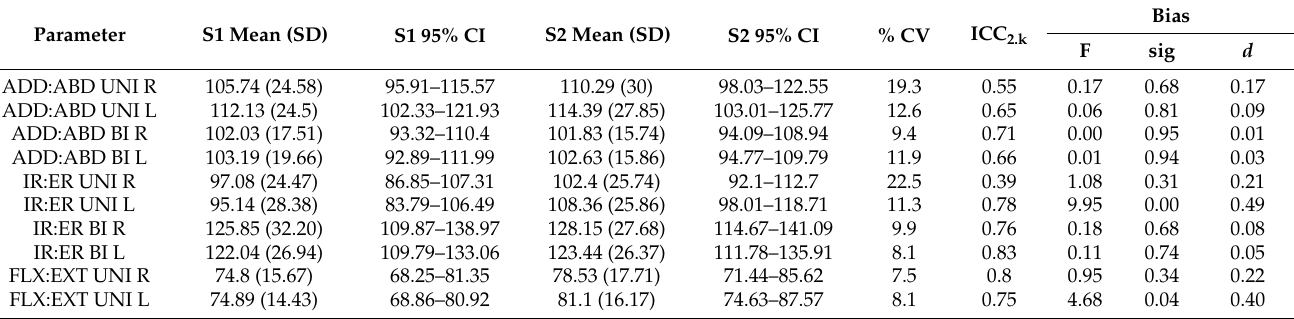
Table 3. Intra-session reliability-peak torque hip agonist:antagonist ratio